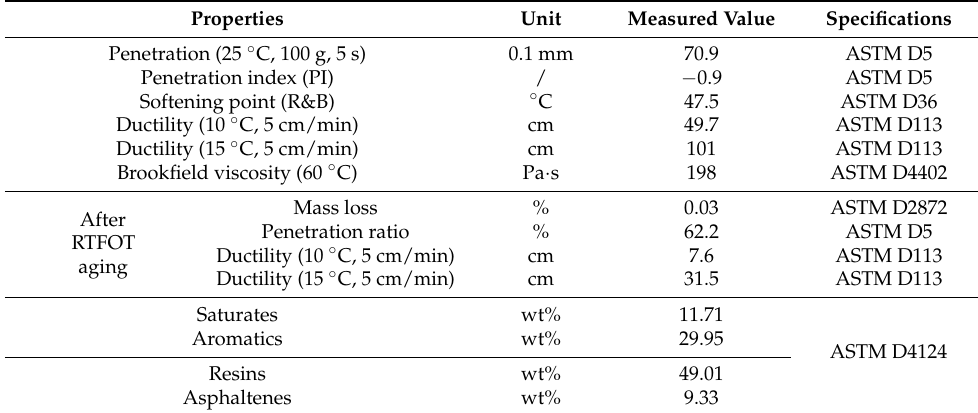
Table 1. Testing results of basic properties of SK-70 base asphalt.